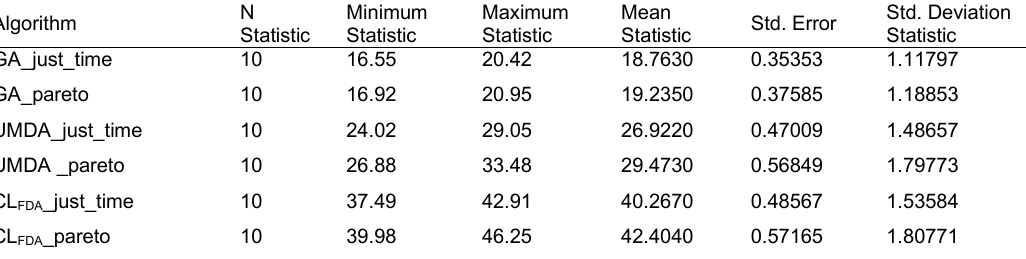
Table 7. Descriptive analysis, variable Execution_time , j30_17 dataset